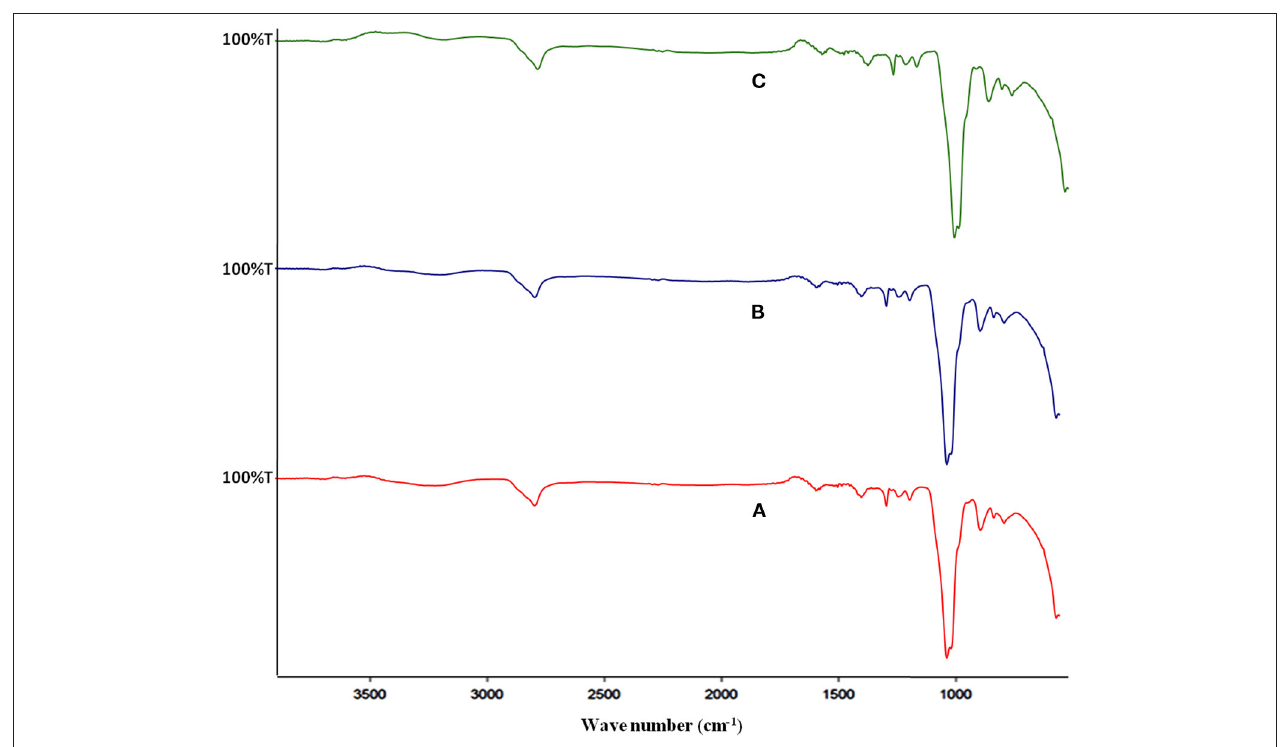
FIGURE 2 | FT-IR spectra of different pectin samples, where (A–C) represents pectin from Mosambi, Kinnow, and Orange peels, respectively.